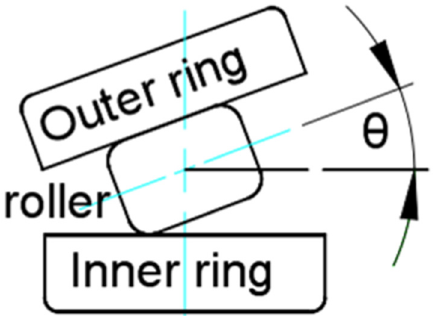
Figure 1. Schematic diagram of the bearing misalignment (angle θ , existing between the rollers and inner ring, is often referred to as the tilting angle of the roller) [21].